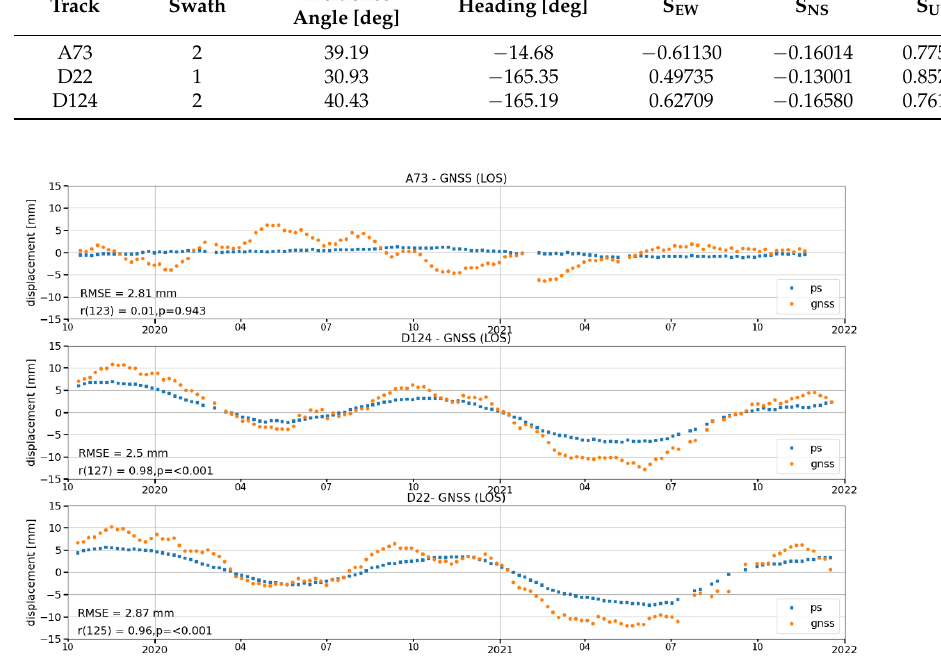
Figure 12. Conversion of GNSS time series to LOS by tracks for patch 597 in Figure 5. For individual tracks, we calculated RMS errors and correlation coefficients between GNSS and PSInSAR results (see Table 6). Table 6. RMS errors for each calculated direction.